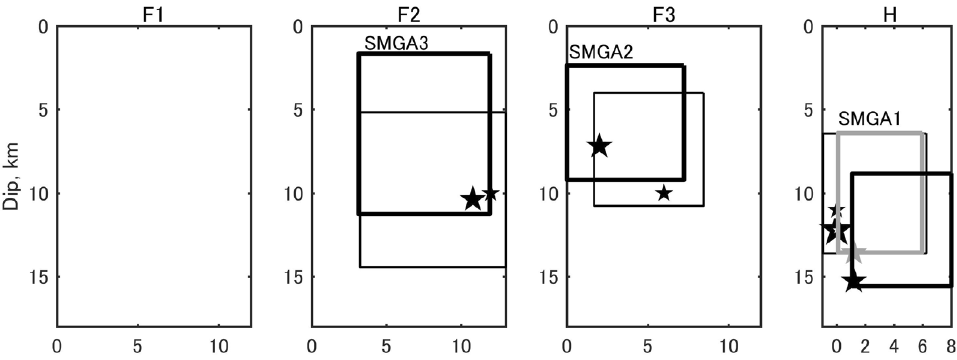
Fig. 8 The locations and rupture initiation points of SMGAs in this study (thick lines and large stars) compared with model of Somei et al. (2019) (thin lines and small stars). A rectangle in a black line and star indicate the location and rupture initiation point of SMGA1 from the inversion model, while that in a gray line and star indicate those from the tuned model